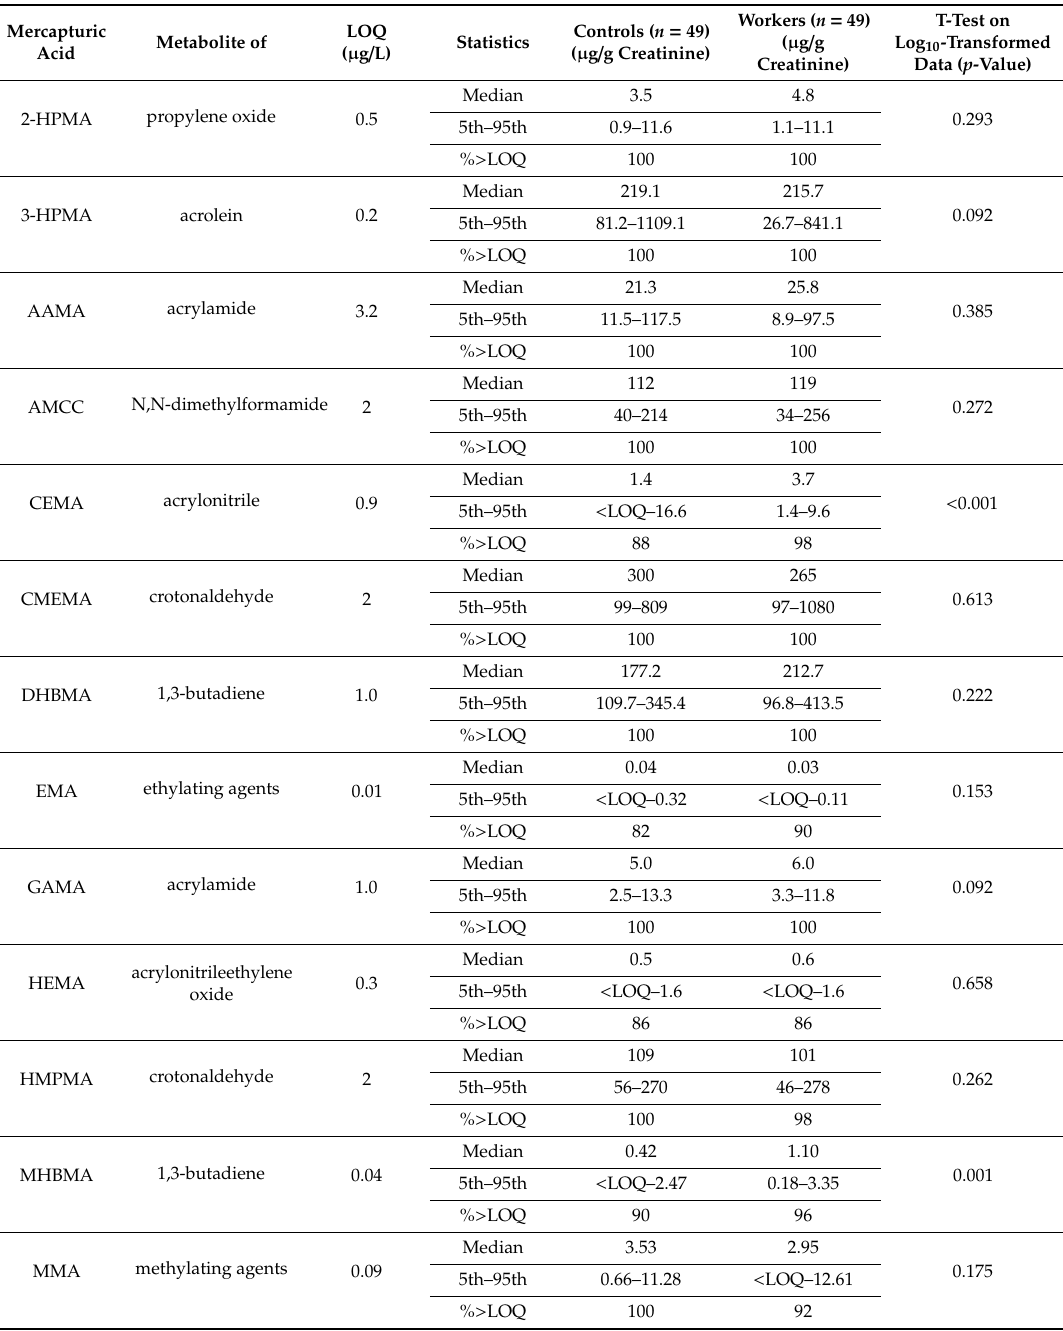
Table 2. Median, 5th, and 95th percentile for the levels of mercapturic acids in subjects’ urine samples, expressed as µ g / g of creatinine, after grouping by controls and workers. For each compound, the limit of quantitation (LOQ) is also reported, along with the percentage of quantified samples. Finally, the P-value of the Student’s T-test performed on log 10 -transformed values is reported to evaluate di ff erences between the two